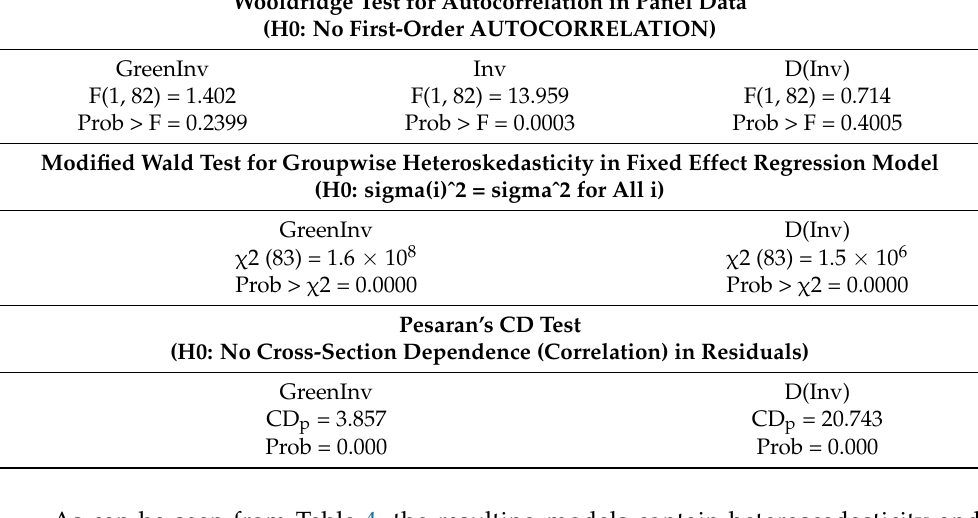
Table 4. Tests for heteroscedasticity, for autocorrelation in panel data, for cross-section dependence in residuals. Wooldridge Test for Autocorrelation in Panel Data